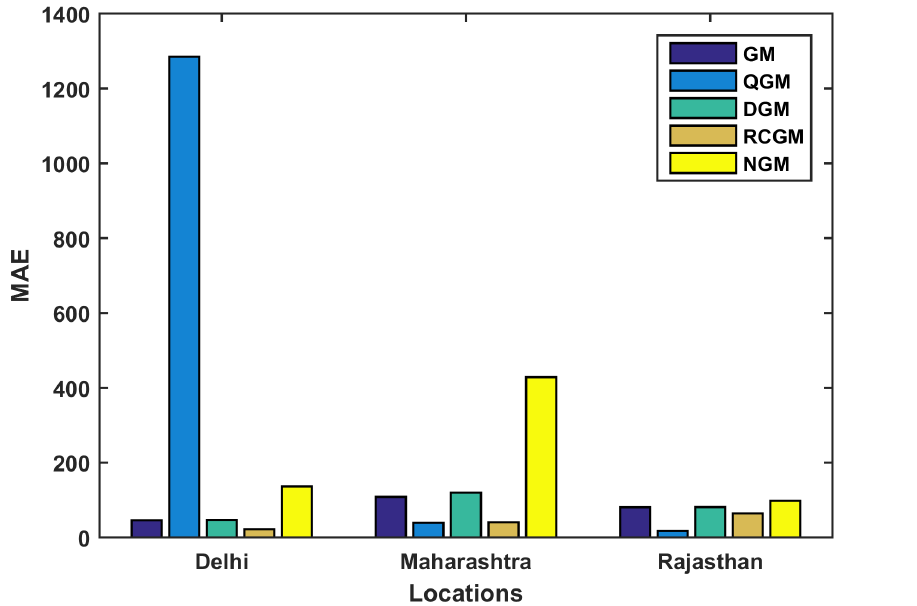
Figure 4. Forecasting Results-MAE.